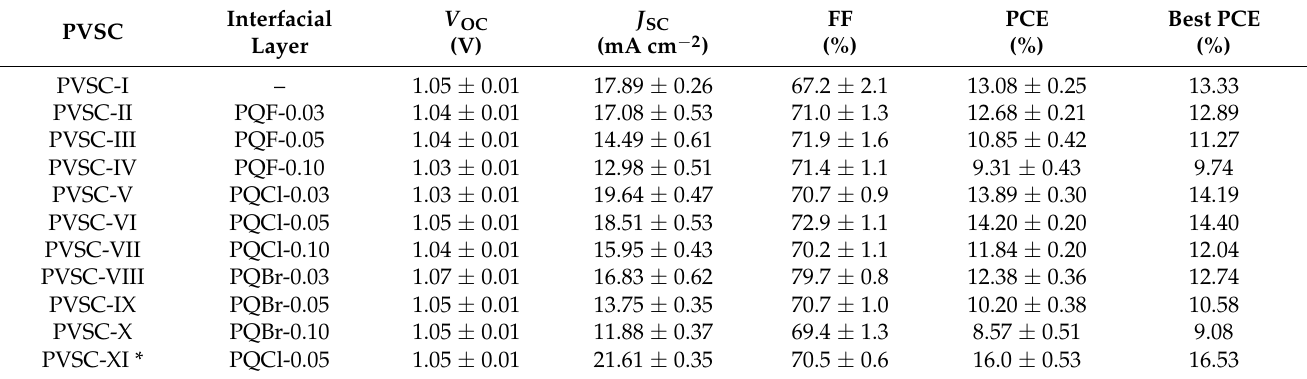
Table 3. PV performance data of PVSCs incorporating the cellulose derivative–modified NiO x HTLs.